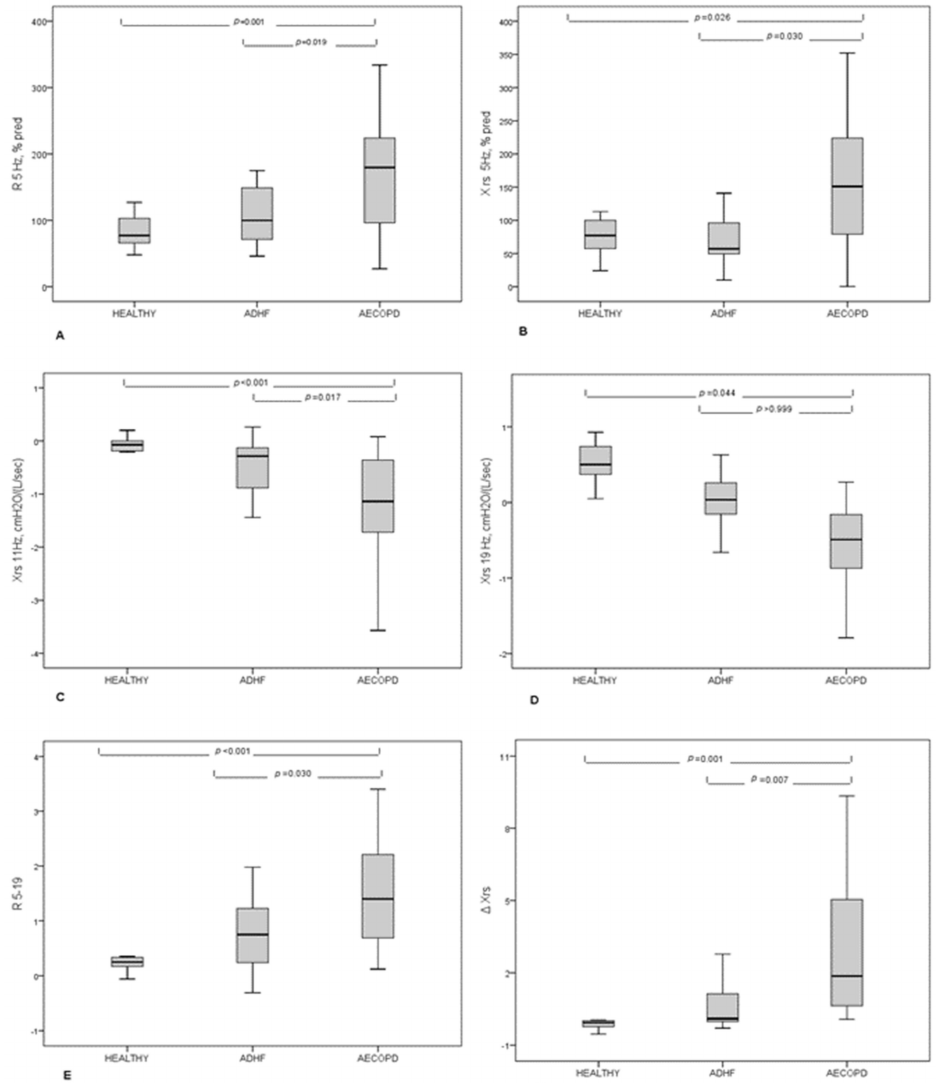
Figure 1. FOT results in patients with AECOPD, ADHF, and healthy subjects. ( A ) Resistance measured at 5 Hz expressed as percentage of predicted value; ( B ) Reactance measured at 5 Hz, expressed as a percentage of predicted values; ( C ) Reactance measured at 11 Hz; ( D ) Reactance measured at 19 Hz; ( E ) Difference between resistance measured at 5 Hz and 19 Hz; ( F ) Mean inspiratory minus mean expiratory reactance expressed as ∆